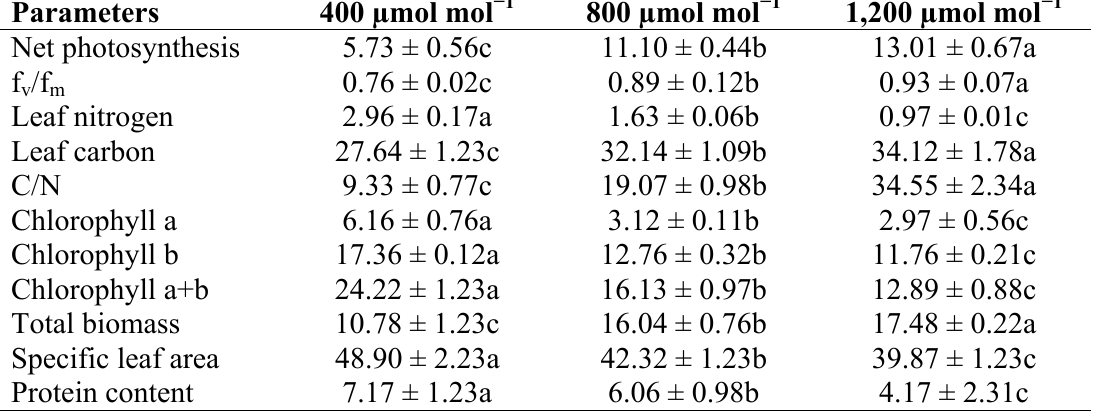
All analyses are mean ± standard error of mean (SEM), N = 15. Means not sharing a common single letter were significantly different at P ≤